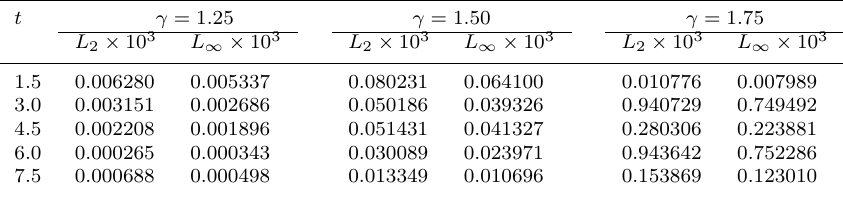
The comparison of the error norms of the diffusion-wave problem for M = 40, ∆t = 0 . 0015 and t f = 3 . 75. t γ = 1 . 25 γ = 1 . 50 γ = 1 . 75 L 2 × 10 3 L ∞ × 10 3 L 2 × 10